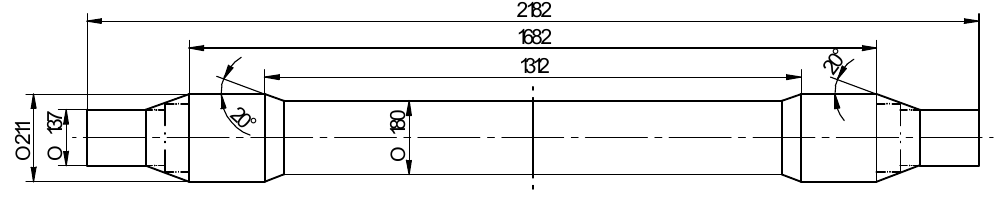
Figure 1. Analyzed railway axle (in a rolled form).